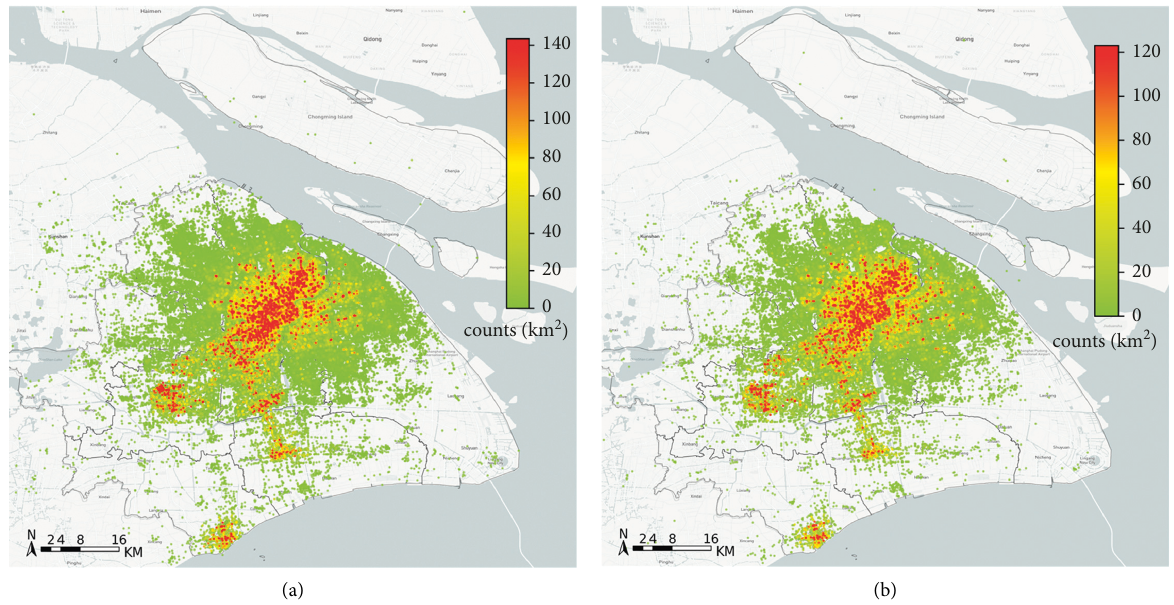
Figure 1: Spatial distribution of DLBS trips’ origin point (unit: counts/km 2 ). (a) May 6 th (Weekday). (b) May 12 th (Weekend).